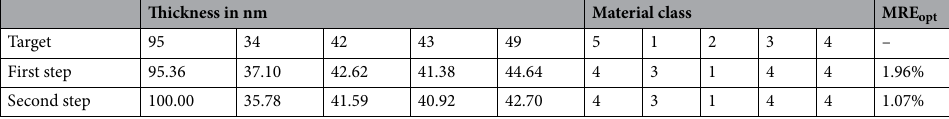
Table 2. Optimized particle parameters targeting an example configuration after the first and second optimization step.